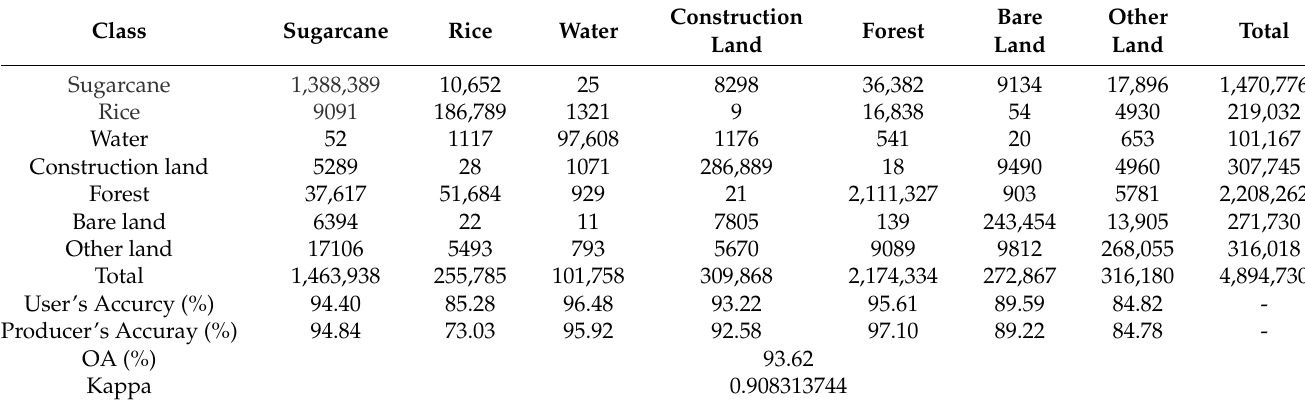
Table 11. Accuracy evaluation table of classification results in 2019.